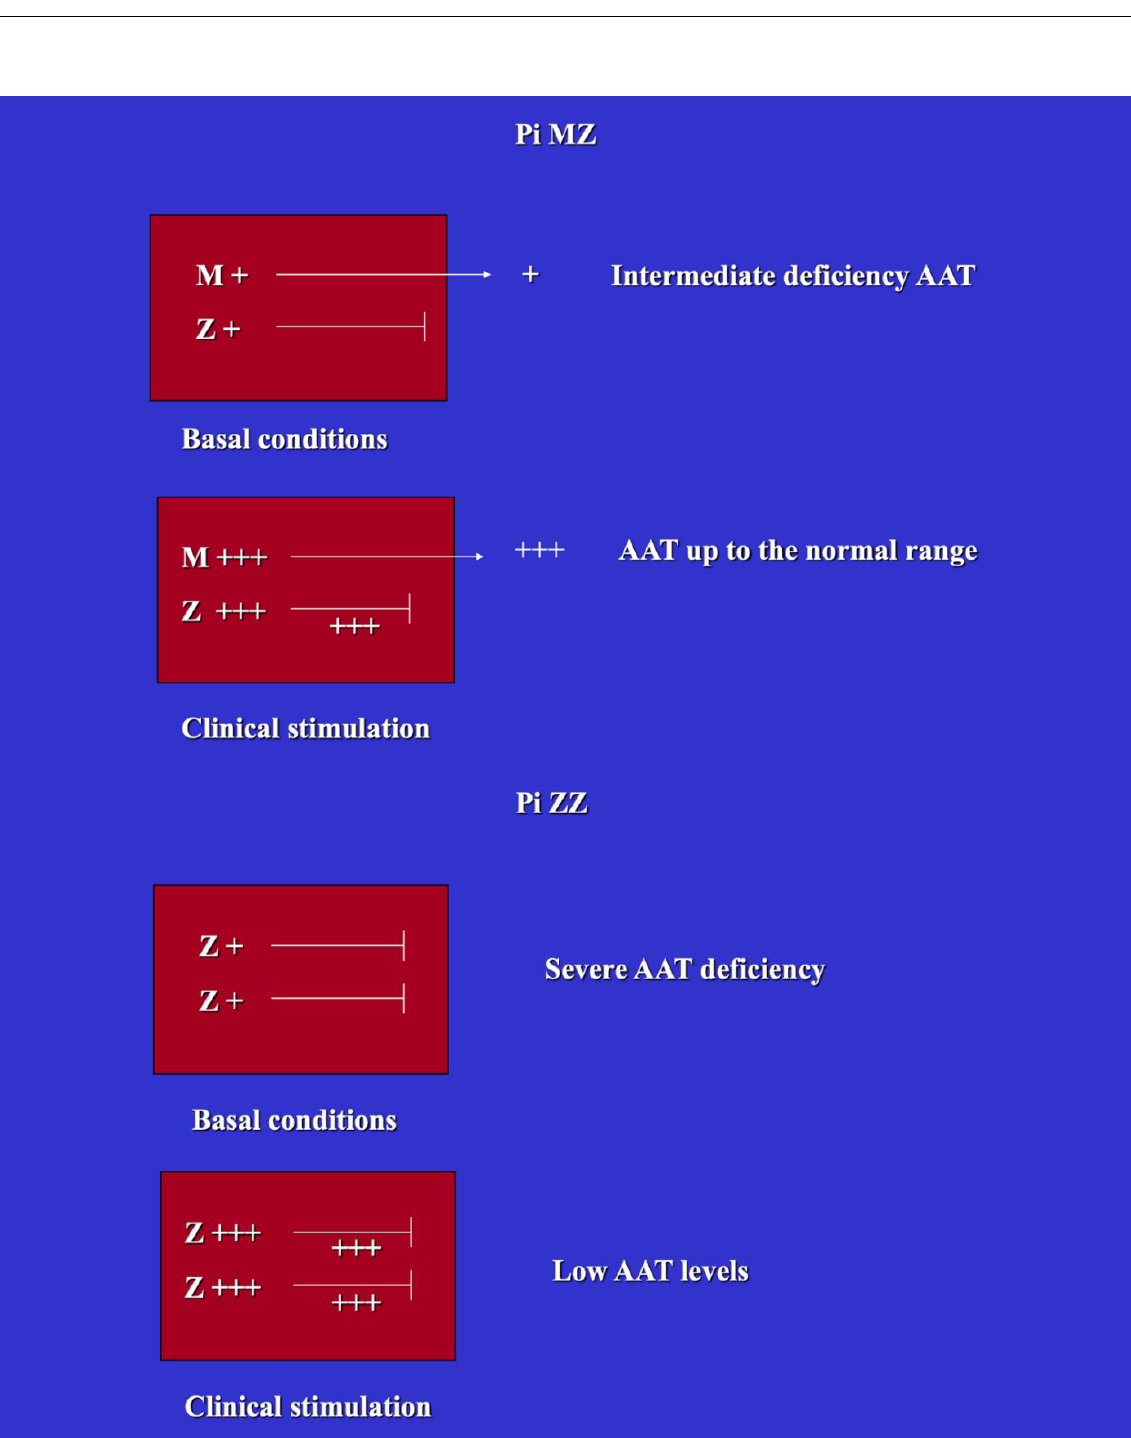
Figure 2. Schematic representation of the “R-SB” phenomenon in heterozygous (Pi MZ) and homozygous (Pi ZZ) AATD. Under basal conditions, Pi MZ individuals show a partial (intermediate) AAT deficiency because 85% of the Z fraction is not exported. Under conditions of clinical stimulations, the M fraction is increased in synthesis and secretion and results in serum AAT elevation. In Pi Z phenotype, the serum AAT levels are very low in both basal and stimulatory conditions because both Z fractions are retained within the cells.